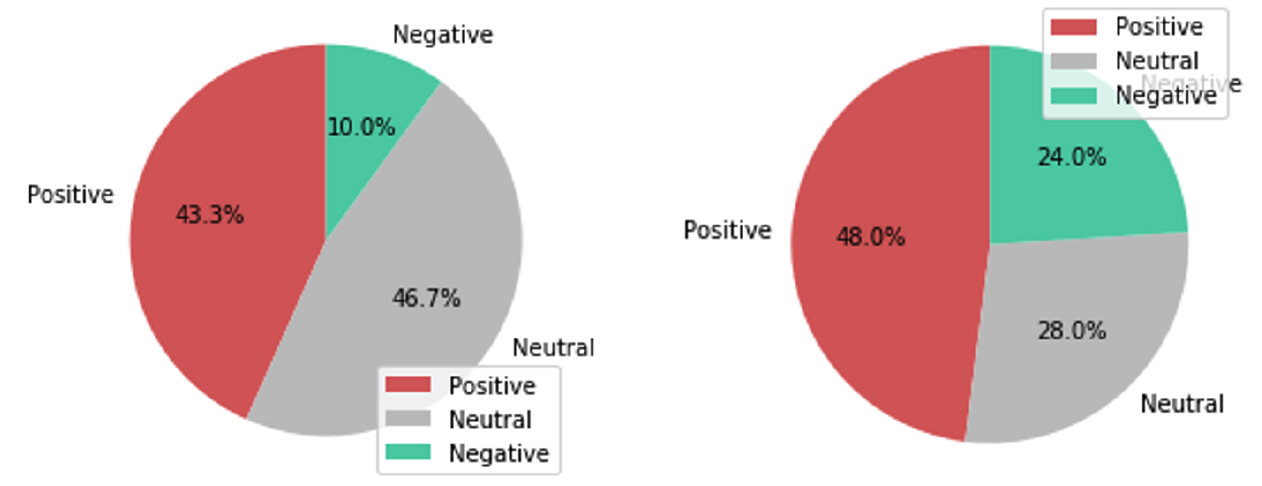
Figure 3. Sentiment analysis for StockTwits ( left piechart) and Twitter ( right piechart) datasets using VADER.